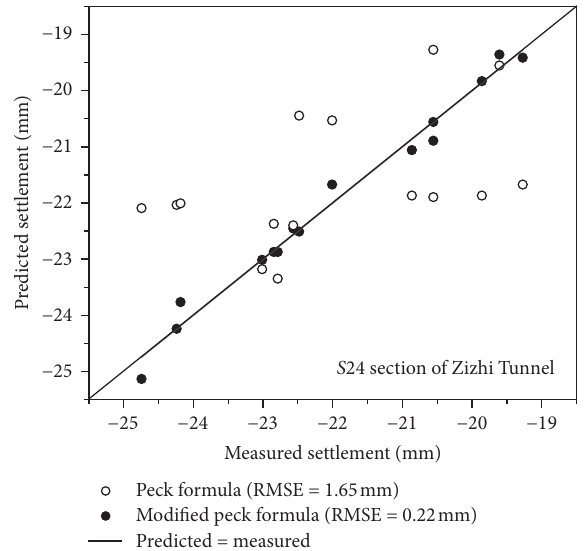
Figure 13: Comparison of predicted settlements for the S 24 section inside the river-affected